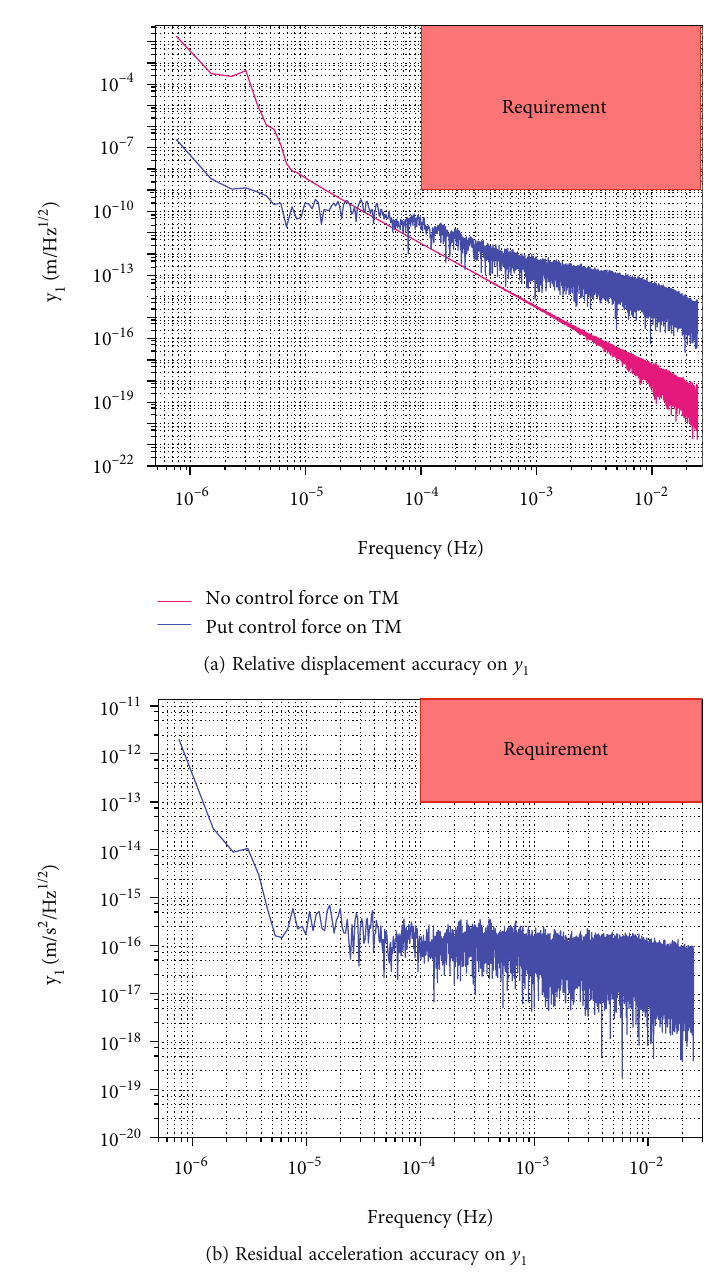
Figure 10: The displacement accuracy and residual acceleration accuracy of the relative motion on y